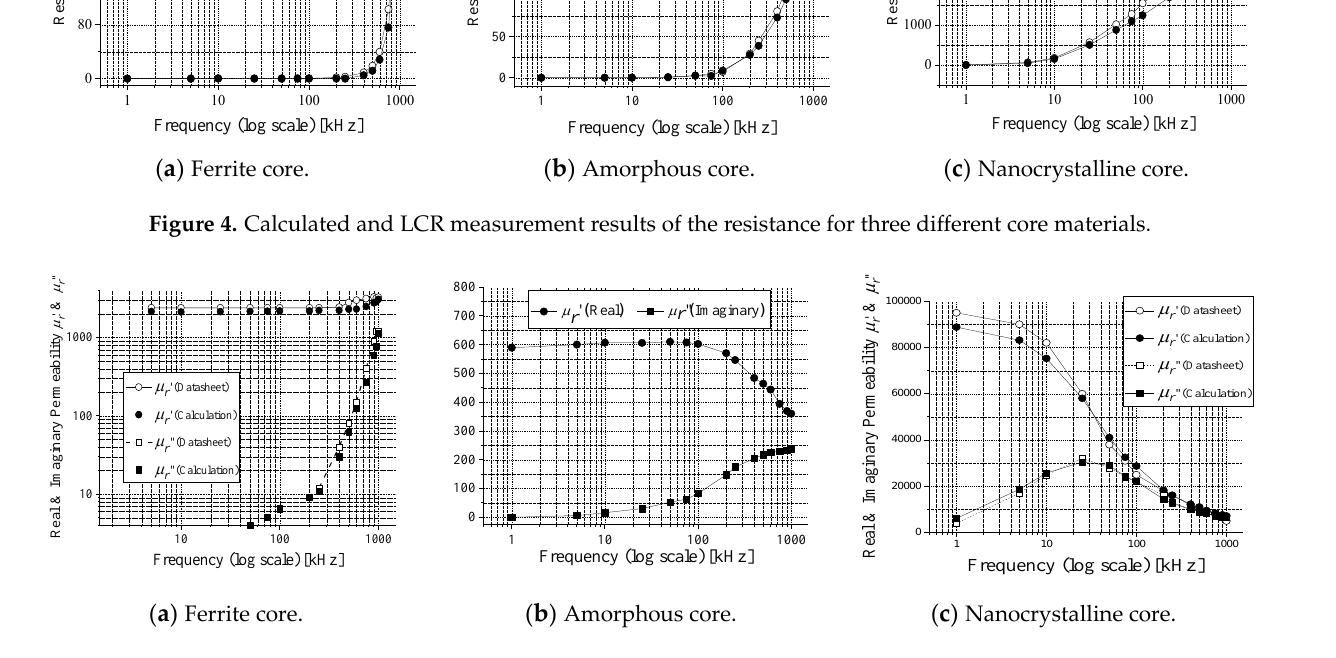
Figure 6. Calculated B e and measured I e w.r.t. the frequency for the test condition. (the ferrite core PM11 case). All the calculated results w.r.t. the different operating frequency are summarized in Table 2. Magnetic loss tangent tan δ μ is defined as μ ″/ μ ′, which represents the magnetic core loss and can be usefully utilized for a finite-element-method (FEM) simulation anal- ysis [3]. Magnetic loss tangent δ μ in Table 2 is essential to specify the core loss resistance modeling from the 3D FEM simulation analysis [2,3]. Based on the core loss resistance obtained by magnetic loss tangent δ μ , the static core loss resistance can be obtained to analyze the core loss of the magnetic components for power converters and wireless power transfer systems. According to the results of tan δ μ in Table 2, the ferrite core is superior to the amorphous core and nanocrystalline core for coil loss term. The complex permeability of the amorphous core is relatively lower than the others. The nanocrystal- line core has very high real permeability, i.e., the core can be highly minimized. However, the imaginary permeability is also very high, i.e., the nanocrystalline core is of inferior core efficiency, although the magnetic component can be minimized by the nanocrystal- line core. From the measured results in Table 2, the core loss of amorphous core may be almost 2.7 times larger than that of ferrite core at f s = 10 k Hz under the same physical and operating conditions. If the operating frequency increases, the loss gap significantly in- creases. Therefore, in terms of the low core loss and high-frequency characteristics, the ferrite core is recommended. On the other hand, the nanocrystalline core is recommended for compact magnetic core. According to the magnetic results obtained by the proposed calculation methodology, the optimal magnetic core can be appropriately selected at the specified operating frequency condition.